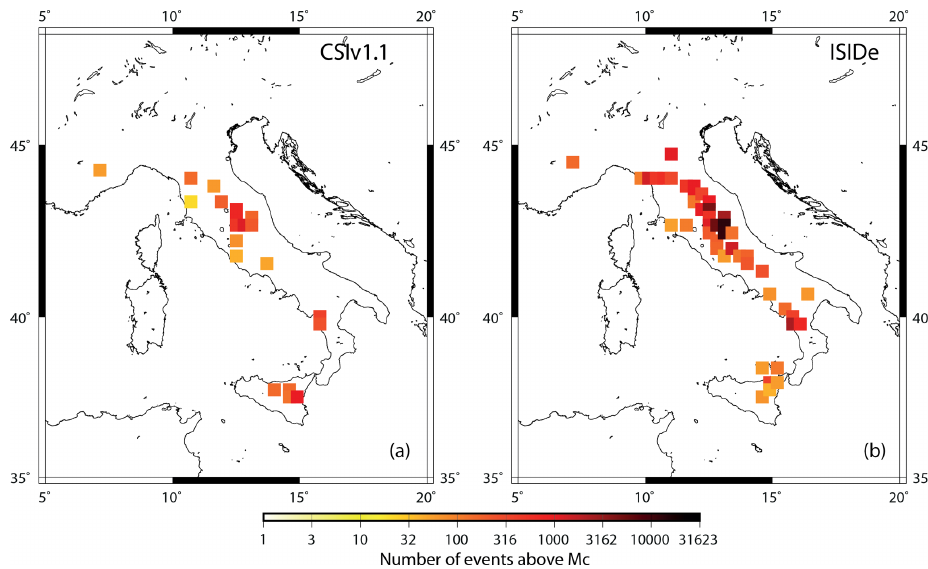
Figure 14. Maps of cells for which FLEM values are tested, on the CSiv1.1 ( a , 20 cells) and ISIDe ( b , 45 cells) databases (Tables S1 and S2). Colours are scaled with the number of events above the estimated completeness magnitude, M c . In these cells the magnitude of events is distributed accordingly using a DTGR law, with a b value equal to